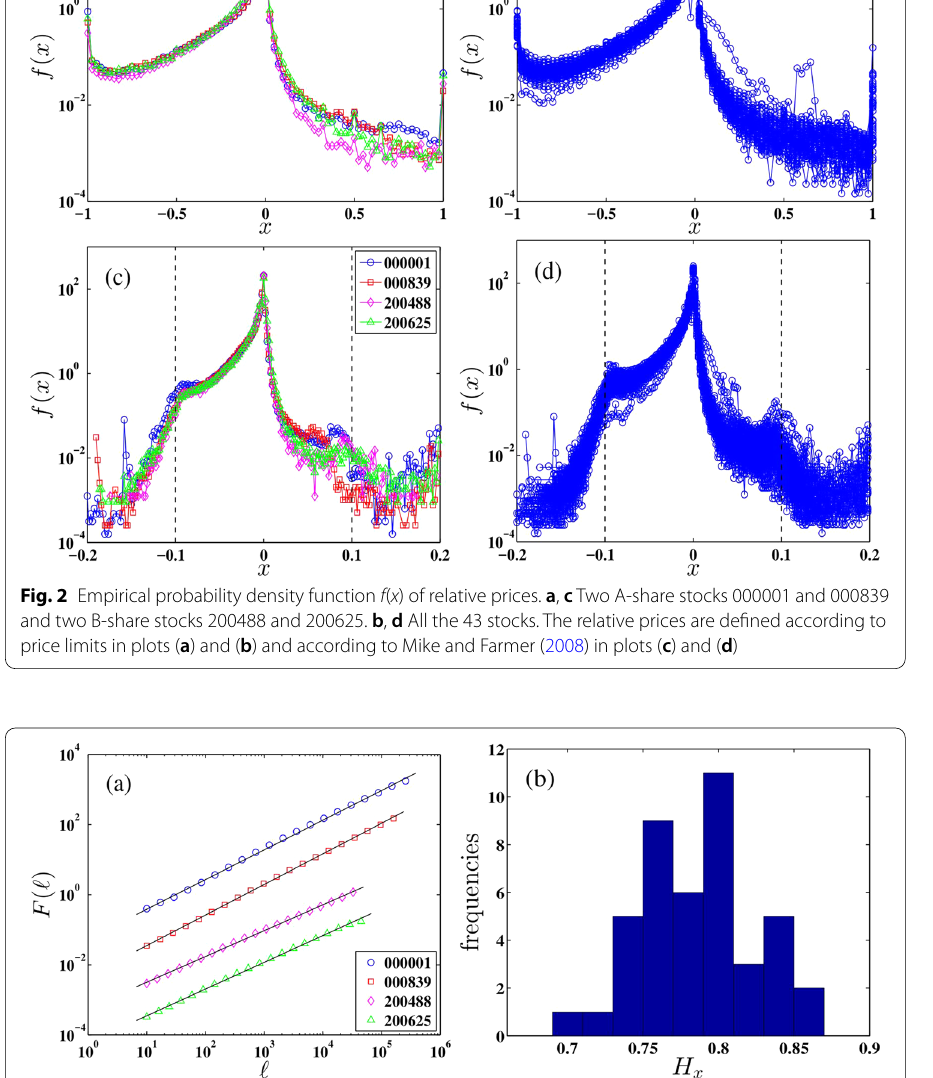
prices of placed orders have a long memory. The histogram of the Hurst exponents of all stocks is showed in Fig. 3b, which confirms the long memory of relative prices in all stocks. According to Table 2, the average Hurst exponents are H x , A 0.808 0.030 for A shares and all stocks, � � = ± means that stronger persistence exists in relative prices of A shares in the year 2003. We